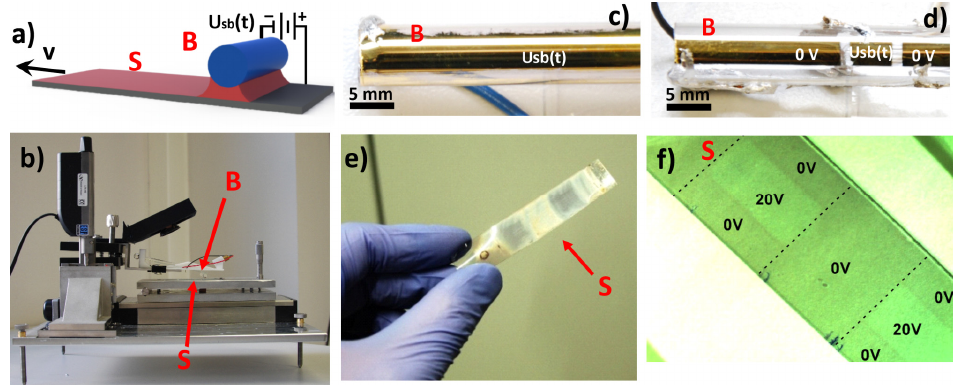
Figure 1. ( a ) Sketch and ( b ) photo of home-built device for the horizontal-dip coating process of a conductive polymer composite with an electrically modified film structure. An electric field is provided by a pulsed voltage Usb ( t ) applied between ( c ) one central or ( d ) multiple separated metallic electrode(s) on the glass coating barrier (B) and the conductive substrate (S). ( e ) Electrically modified film structure of the semiconductor-insulator polymer composite (RP3HT/PEG-PCL) on a flexible substrate with coating barrier ( c ), indicating the processability in large-area fabrication. ( f ) Modified film structure of the RP3HT/PEG-PCL composite on rigid ITO-coated glass slide fabricated with the coating barrier with multiple electrodes ( d